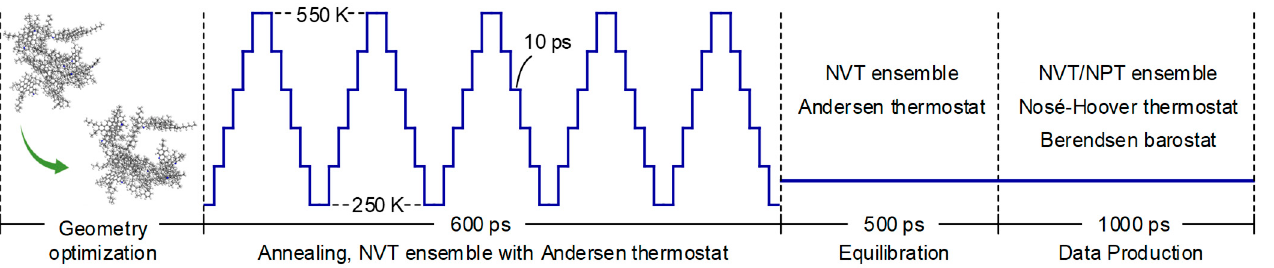
Figure 3. Four-step process employed to bring the system to equilibrium with physically sound dynamics (time not to scale).